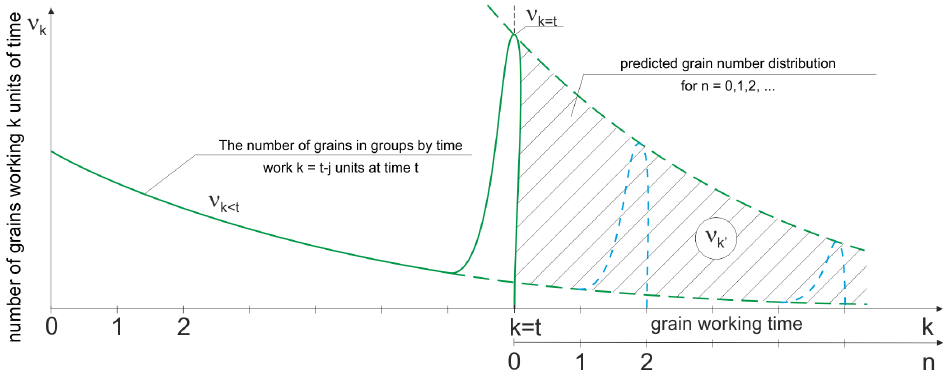
Figure 1. The determined (up to k = t ) and predicted ( k > t ) distribution of the number of grains at the n = 0,1,2, . . .